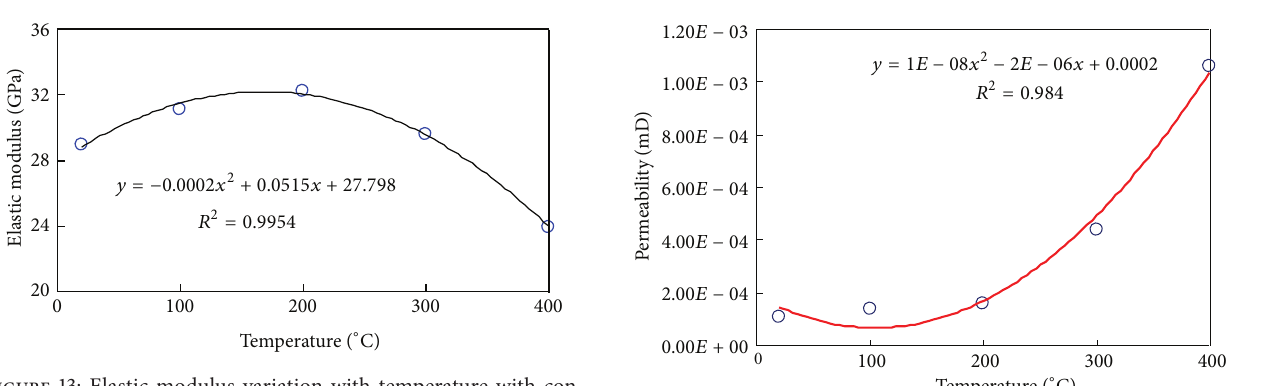
Figure 13: Elastic modulus variation with temperature with con- stant confining pressure.